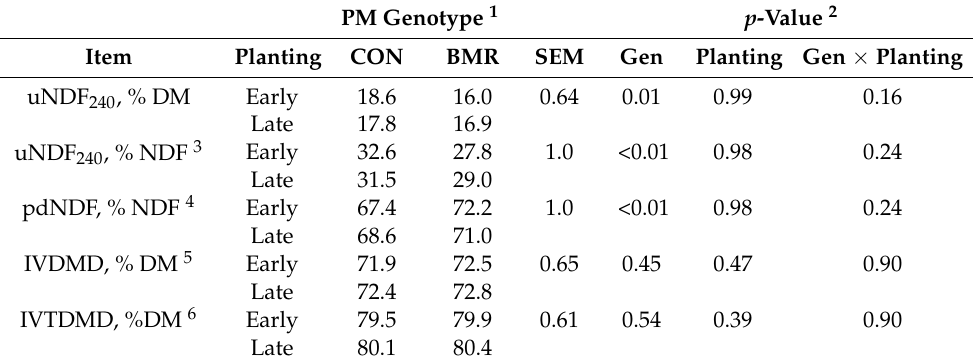
Table 2. Undigestible NDF and in-vitro DM digestibility of pearl millet genotypes planted at different dates (Trial 1). PM Genotype 1 p -Value 2